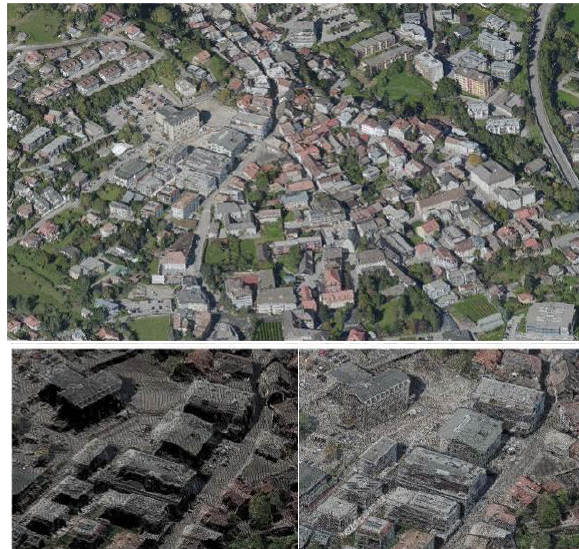
Figure 3. 3D point cloud of Imst extracted with Pix4D using nadir + oblique images (top). Close up views (bottom) in 3D point cloud extracted using only nadir (left) and nadir + oblique images (right). In addition, some height profiles were generated in the nadir, nadir + oblique and LiDAR point clouds in correspondence of a selection of buildings for comparisons (Figure 4).